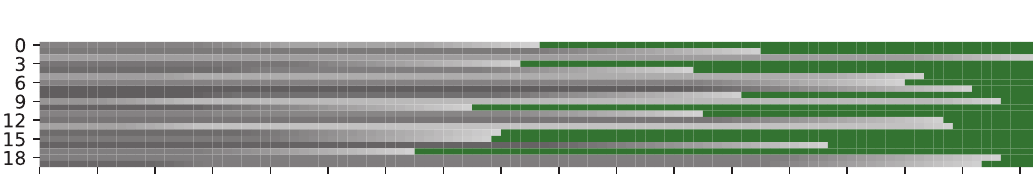
( a ) Status of charging from EV 0 to 19 using earliest deadline rule with P lim “ 25 kW. Legend: N/A , W AITING , C HARGING , F ORCED , C HARGED .